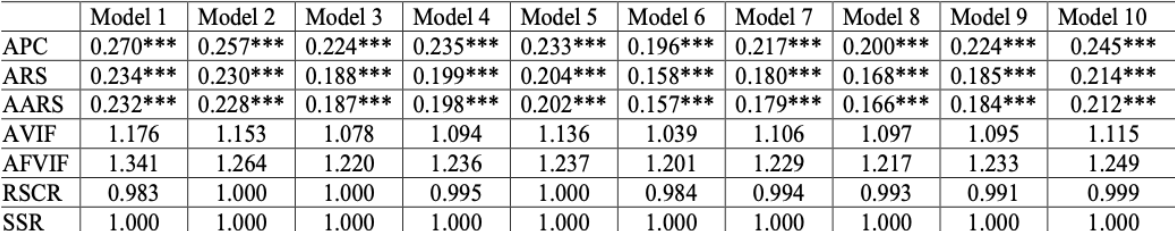
Table 2: Model fit indices used for the structural